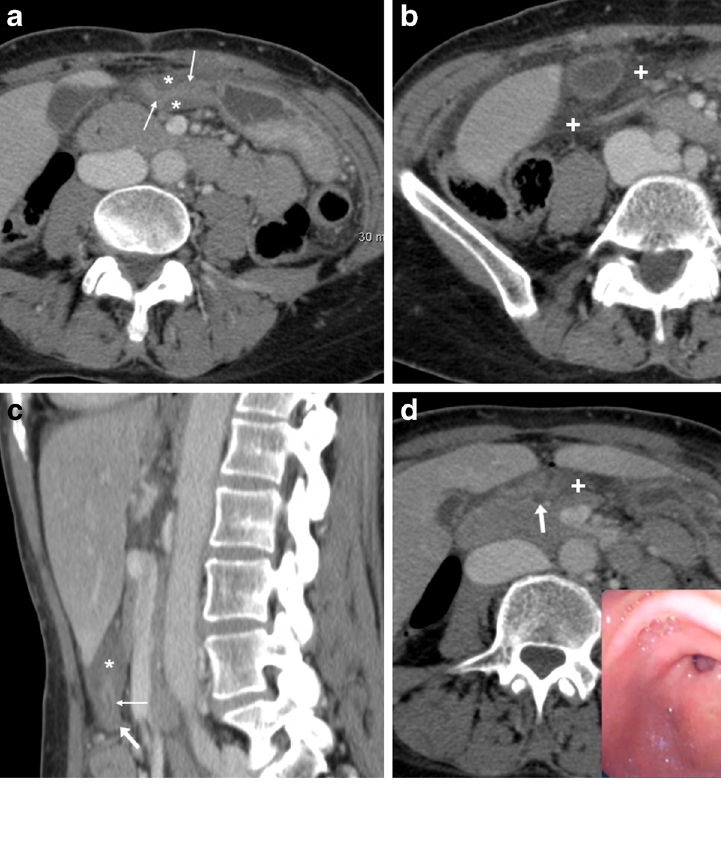
nonsteroidal anti-inflammatory drugs (NSAIDs) intake. Repeated CT revealed increased hypoattenuating mural thickening (*) with mucosal enhancement (thin arrows) of the pylorus and proximal duodenum which spared the anterior aspect, worsened periduodenal inflammatory changes (+), and development of a 2-cm roundish posterior deep ulcer (arrows). Upper digestive endoscopy confirmed a non- malignant retropyloric peptic ulcer. The patient ultimately did well on proton-pump inhibitors (PPI) and anti- Helicobacter pylori triple therapy [Adapted from Open Access ref. no